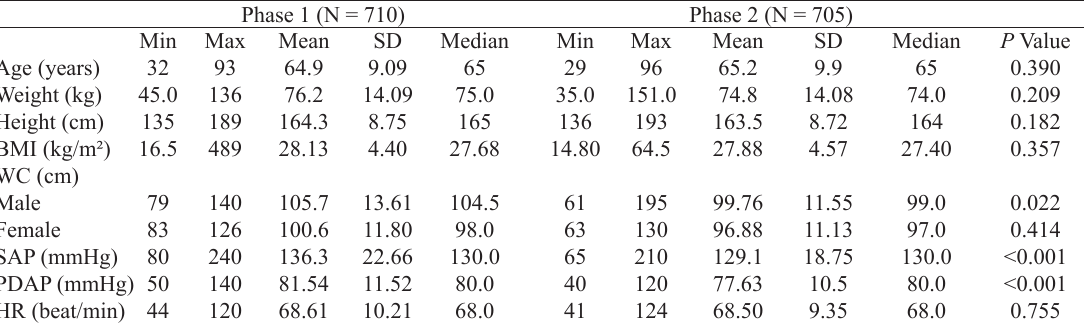
Table 3. Anthropometric measurements.